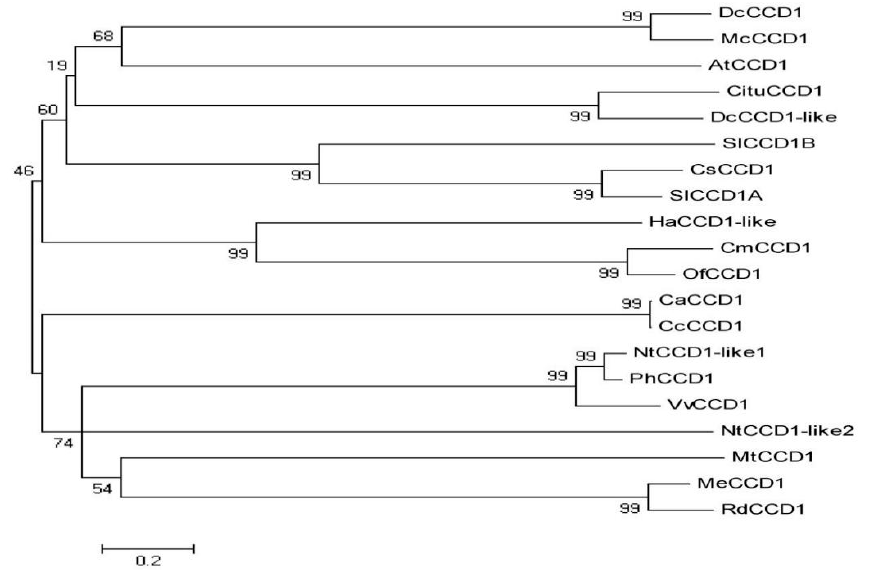
Figure 7. Cluster diagram of phylogenetic relationships of the CCD1s from dicotyledonous plants.